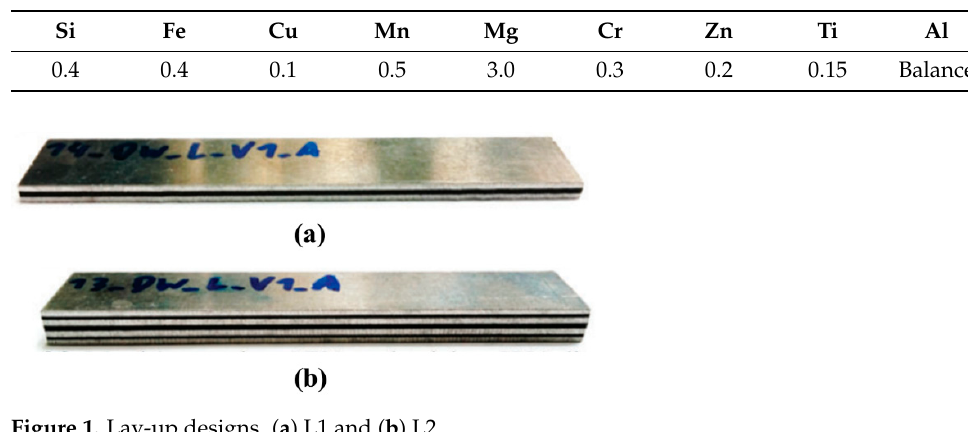
Figure 1. Lay-up designs. ( a ) L1 and ( b ) L2. Table 2. Details of the designed lay-ups.